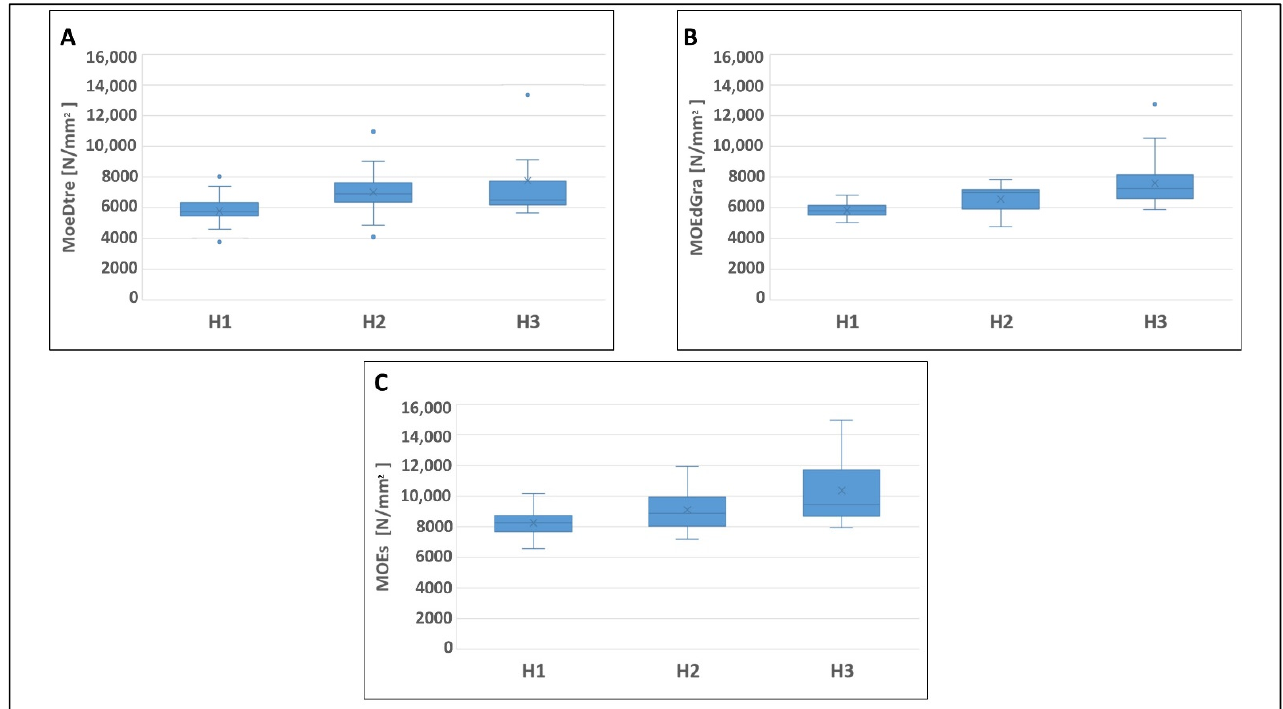
Figure 3. Graphical representation of the modulus of elasticity (MOE) assessed with ( A ) Treesonic on standing trees, ( B ) Resonance Log Grader on green logs, and ( C ) universal testing machine DINA 960 XP (METRO COM, Italy) on conditioned specimens. Table 3. Two-tailed linear correlation between the static modulus of elasticity (MOEs) and sound stress wave velocities acquired with TreeSonic ( VelTre ), Resonance Log Grader ( VelGra ) and dynamic modulus of elasticity obtained with TreeSonic (MOEdTre) and Resonance Log Grader (MOEdGra). N VelTre VelGra MOEdTre MOEdGra MOEs Pearson Corr. 66 0.690 ** 0.726 ** 0.708 ** 0.728 ** VelGra Pearson Corr. 66 0.627 ** 1 - - MOEdGra Pearson Corr. 66 - - 0.607 ** 1